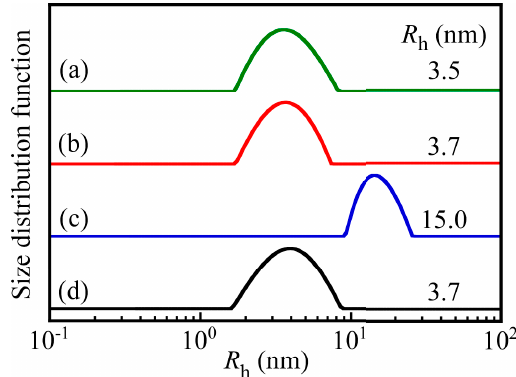
Figure 4. Hydrodynamic radius ( R h ) distributions for ( a ) PNaSS 58 – b – PAA 125 and ( b ) PNaSS 58 – b – PNIPAM 115 in 0.1 M NaCl at pH 3, and the PNaSS 58 – b – PAA 125 /PNaSS 58 – b – PNIPAM 115 complex at ( c ) pH 3 and ( d ) pH 10.